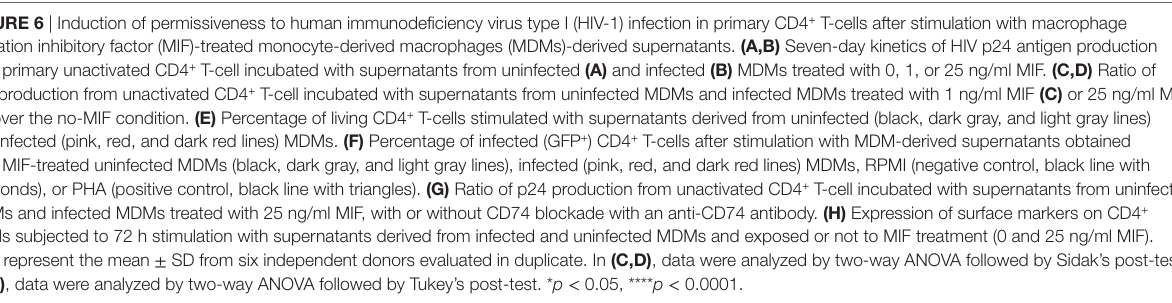
FigUre 6 | Induction of permissiveness to human immunodeficiency virus type I (HIV-1) infection in primary CD4 + T-cells after stimulation with macrophage migration inhibitory factor (MIF)-treated monocyte-derived macrophages (MDMs)-derived supernatants. (a,B) Seven-day kinetics of HIV p24 antigen production from primary unactivated CD4 + T-cell incubated with supernatants from uninfected (a) and infected (B) MDMs treated with 0, 1, or 25 ng/ml MIF. (c,D) Ratio of p24 production from unactivated CD4 + T-cell incubated with supernatants from uninfected MDMs and infected MDMs treated with 1 ng/ml MIF (c) or 25 ng/ml MIF (D) over the no-MIF condition. (e) Percentage of living CD4 + T-cells stimulated with supernatants derived from uninfected (black, dark gray, and light gray lines) and infected (pink, red, and dark red lines) MDMs. (F) Percentage of infected (GFP + ) CD4 + T-cells after stimulation with MDM-derived supernatants obtained from MIF-treated uninfected MDMs (black, dark gray, and light gray lines), infected (pink, red, and dark red lines) MDMs, RPMI (negative control, black line with diamonds), or PHA (positive control, black line with triangles). (g) Ratio of p24 production from unactivated CD4 + T-cell incubated with supernatants from uninfected MDMs and infected MDMs treated with 25 ng/ml MIF, with or without CD74 blockade with an anti-CD74 antibody. (h) Expression of surface markers on CD4 + T-cells subjected to 72 h stimulation with supernatants derived from infected and uninfected MDMs and exposed or not to MIF treatment (0 and 25 ng/ml MIF). Data represent the mean ± SD from six independent donors evaluated in duplicate. In (c,D) , data were analyzed by two-way ANOVA followed by Sidak’s post-test. In (g) , data were analyzed by two-way ANOVA followed by Tukey’s post-test. * p < 0.05, **** p <